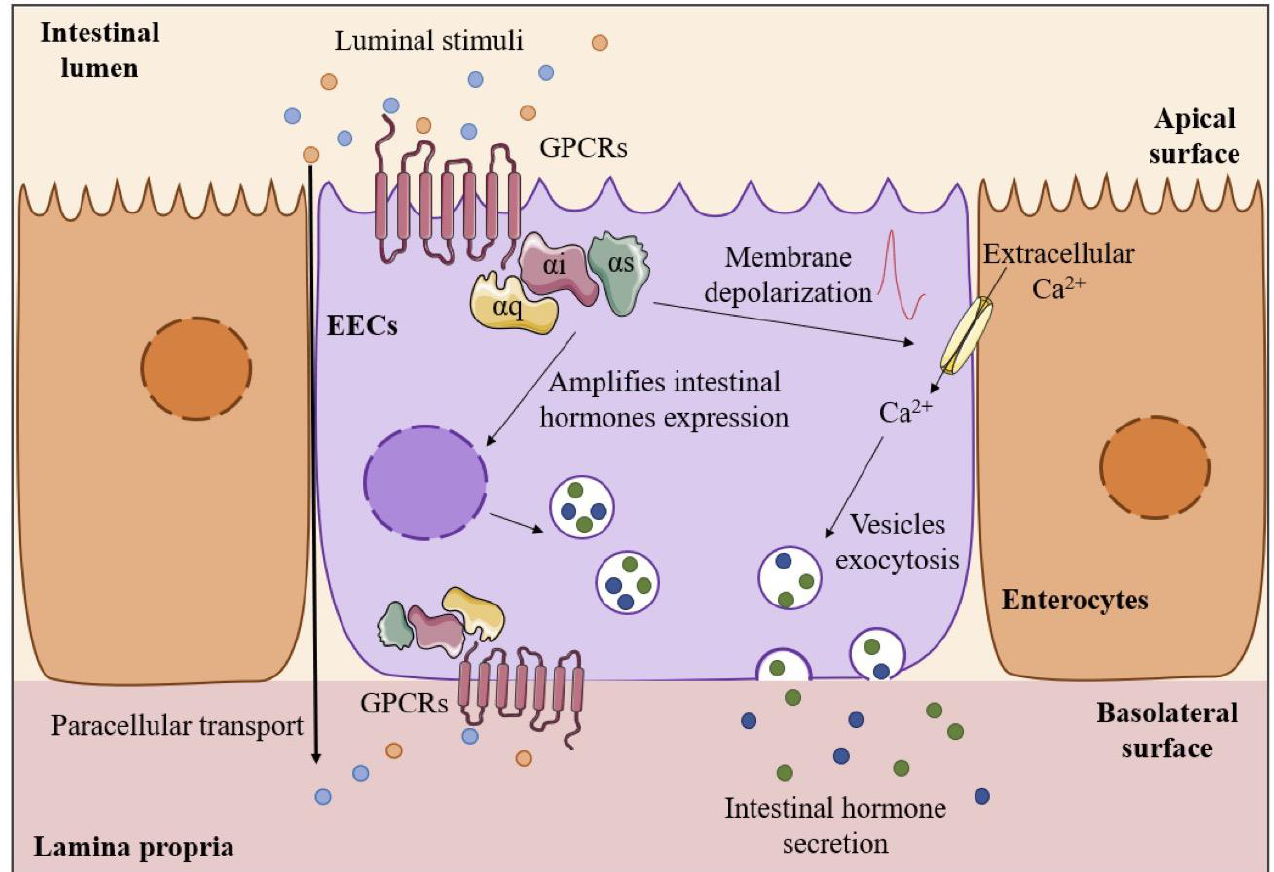
Figure 2. Scheme of EECs as sensors of the luminal intestinal content through G-protein-coupled receptors (GPCRs).